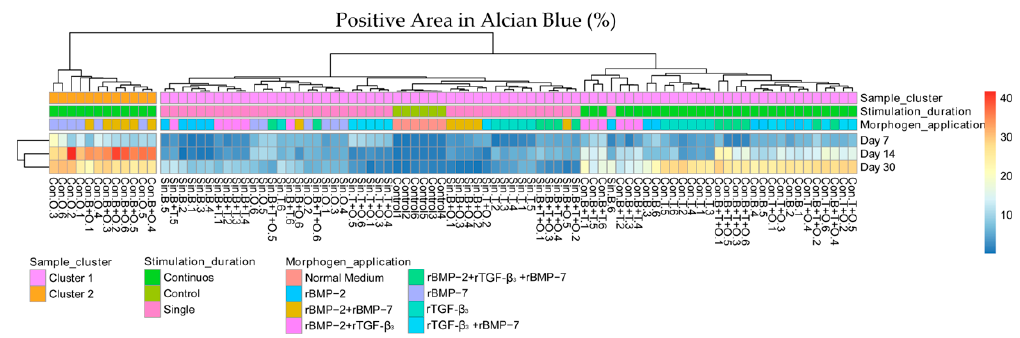
Figure 11. Hierarchical clustering of the alcian blue staining area of all the samples at all culturing time points. The distance measure used in the clustering rows and column was Euclidean, the agglomeration method used to cluster was the average. Con. = Continuous, Sin. = Single, B = rBMP-2 treated group, T = rTGF- β 3 treated group, O = rBMP-7 treated group, B + T = rBMP-2 + rTGF- β 3 treated group, B + O = rBMP-2 + rBMP-7 treated group, T + O = rTGF- β 3 + rBMP-7 treated group, B + T + O = rBMP-2 + rTGF- β 3 + rBMP-7 treated group.